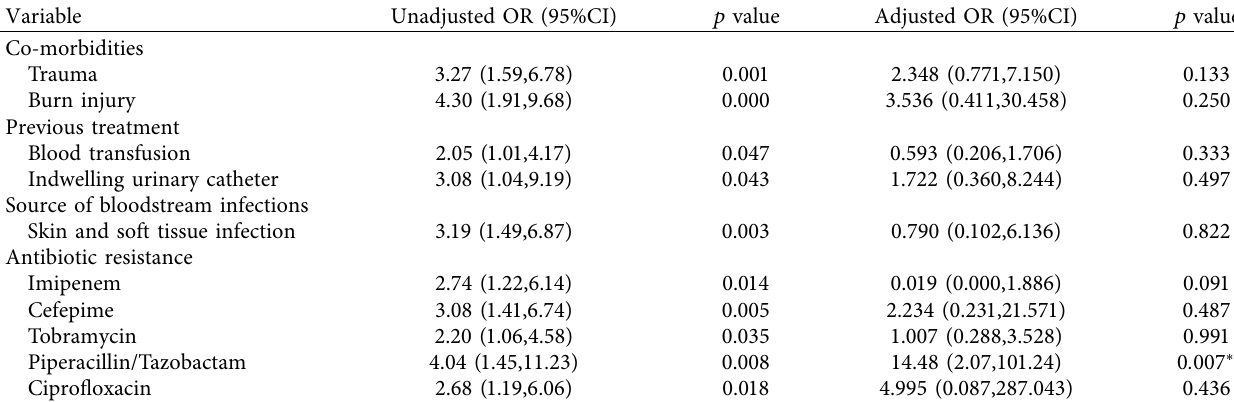
Table 4: Multivariable logistic regression of factors associated with polymicrobial